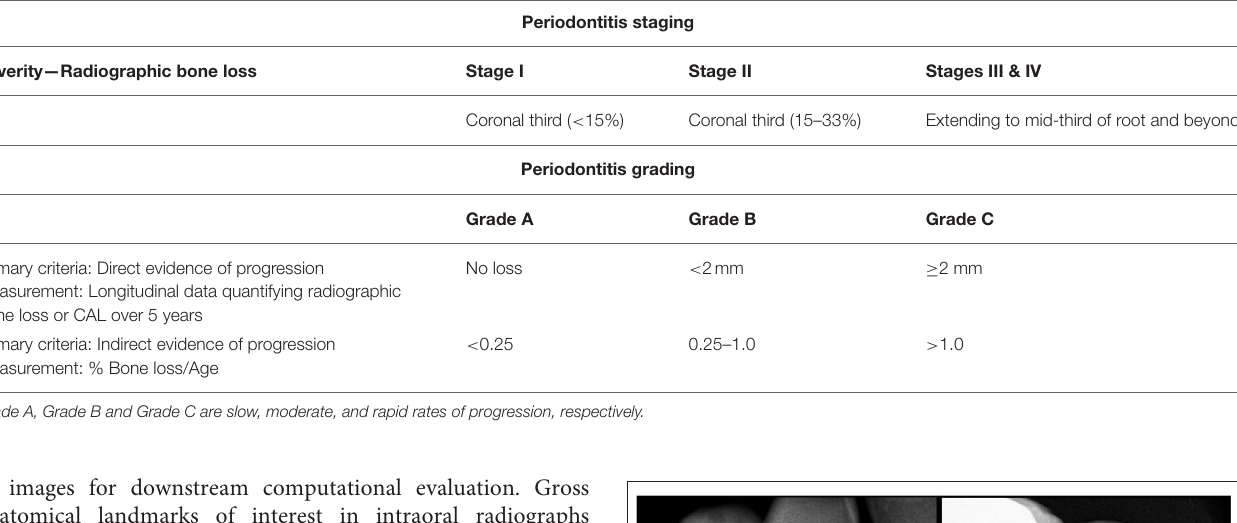
TABLE 1 | Radiographic parameters for determination of periodontitis stage and grade.